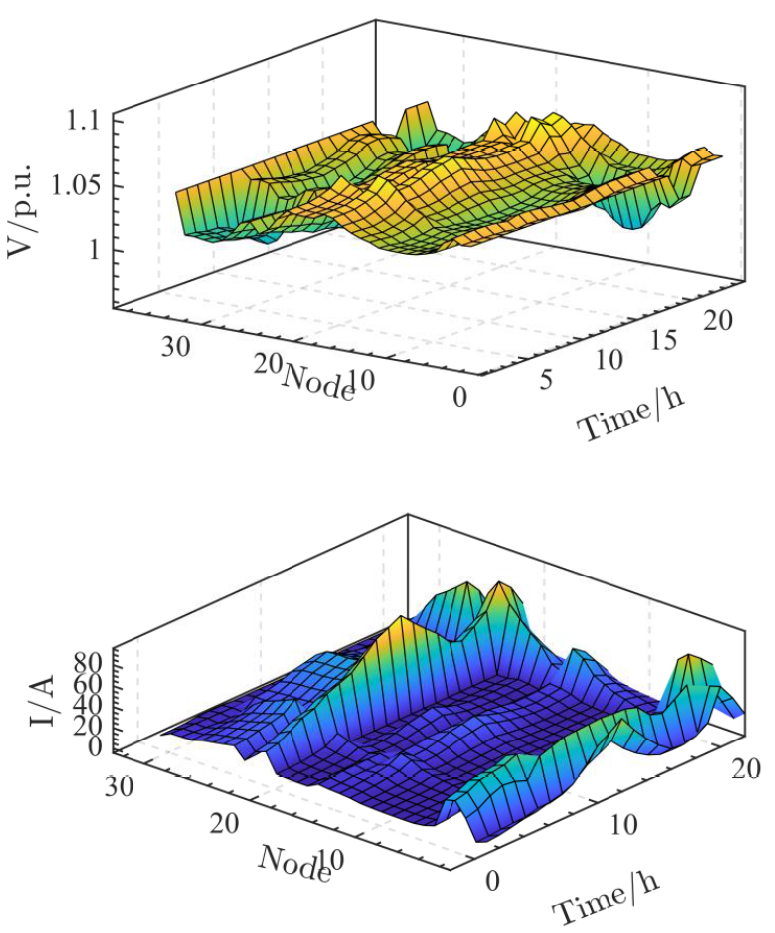
Figure 9. System node voltage and current after scheduling.